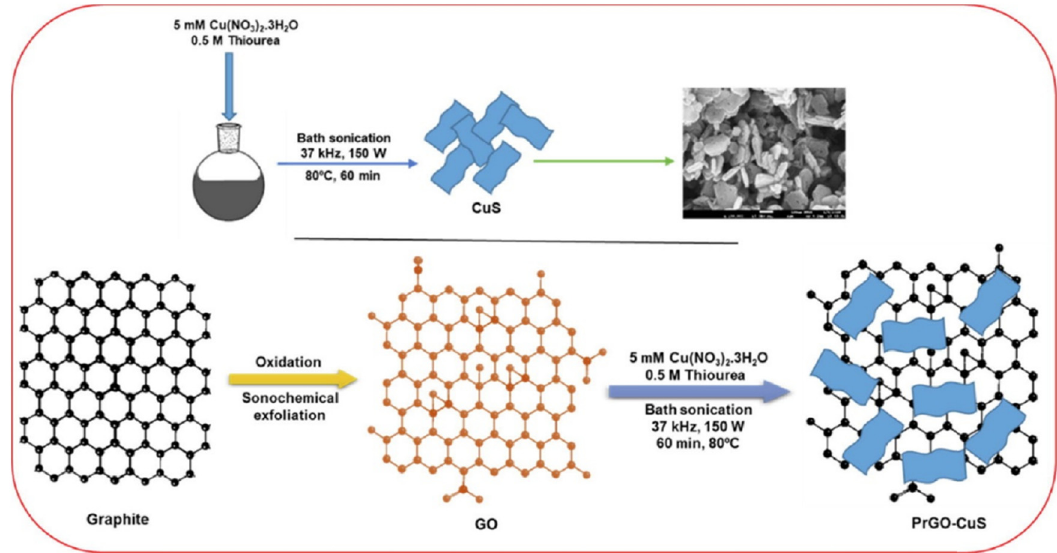
Figure 30: Schematic illustration of the sonochemical preparation of CuS and PrGO – CuS nanocomposite ( 189 )